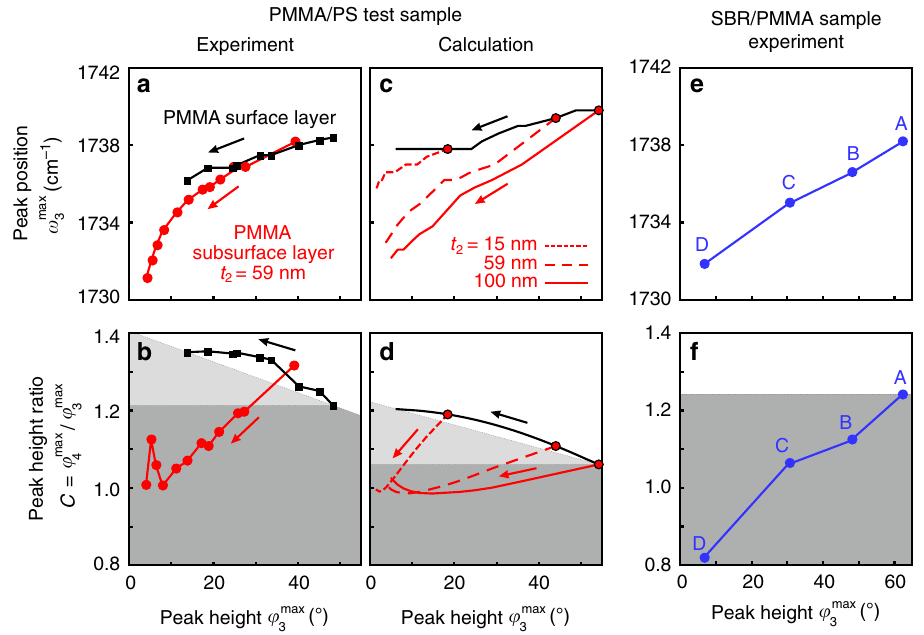
and b peak height ratios C of PMMA surface (black symbols) and 3 (experimental data taken from Fig. 3). Arrows indicate 3 and f peak height ratios C are plotted versus the corresponding peak heights 3